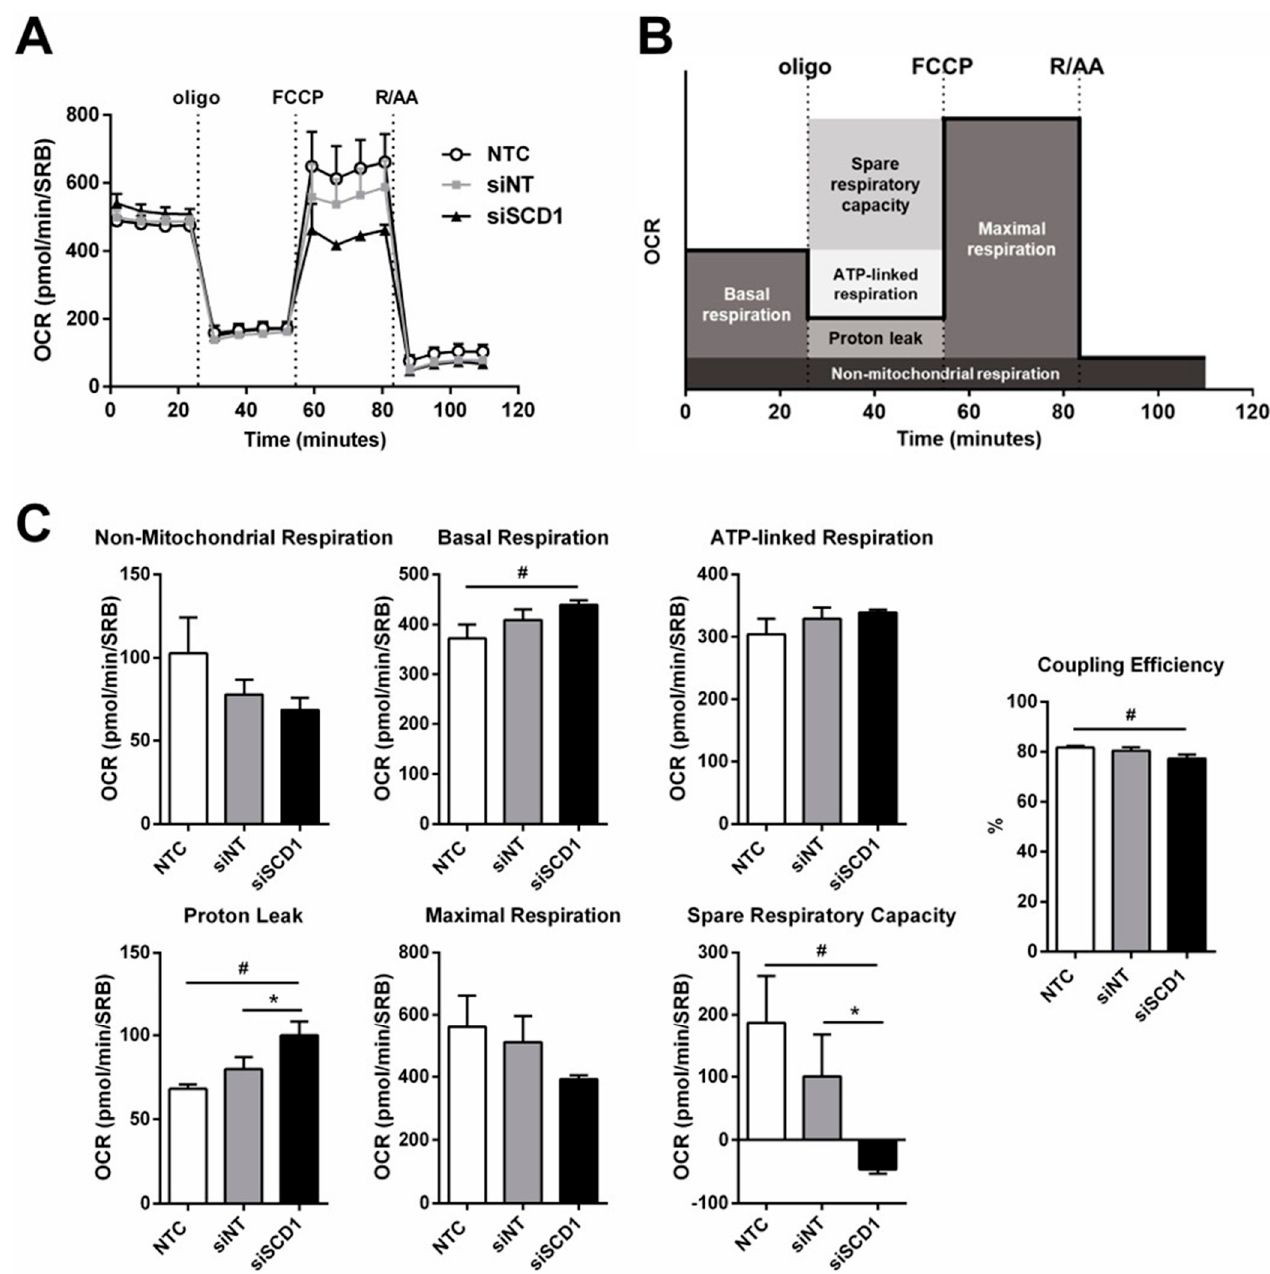
Figure 6. Effect of SCD1 silencing on mitochondrial respiration of U87 cells. Cells grown in medium containing 2% FBS were transfected with an siRNA against SCD1 (siSCD1) or a non-targeting siRNA sequence (siNT) complexed with Lipofectamine RNAiMAX. Sixty-eight hours after transfection, the medium was replaced with XF24 Assay Medium. Oligomycin, FCCP and rotenone plus antimycin A were diluted in XFe24 medium and loaded into the cartridge to achieve the final concentration of 1 µM for each inhibitor. Oxygen consumption rate (OCR) was recorded using a Seahorse XFe24 extracellular flux analyzer and normalized regarding the protein content of each well using the SRB assay. The real-time mitochondrial OCR profiles of non-treated cells (NTC) and cells transfected with siNT and siSCD1 after sequential injections of oligomycin (oligo), FCCP and rotenone plus antimycin A (R/AA) are shown in panel ( A ). Panel ( B ) shows how the mitochondrial respiration parameters displayed in panel ( C ) were extrapolated from an OCR profile ( n = 3; one-way ANOVA followed by Tukey’s test; # p < 0.05, vs. NTC; * p < 0.05 versus siNT).